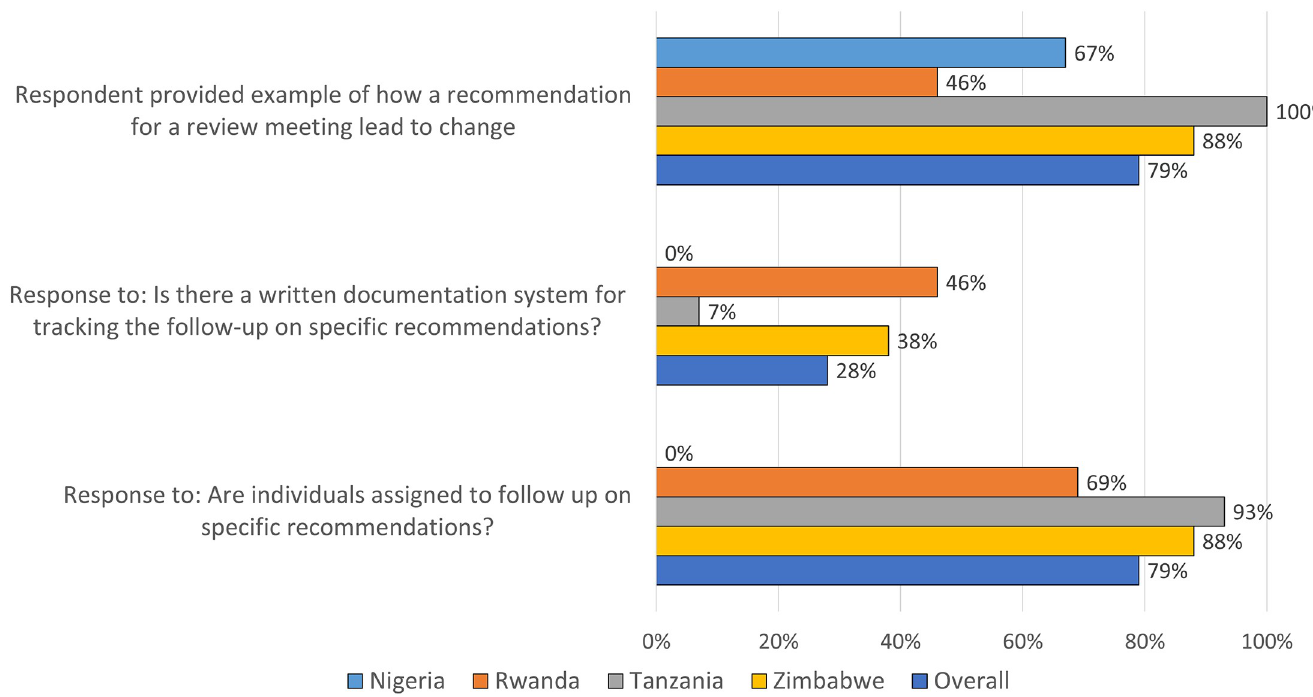
Fig 3. Proportion of facilities reporting follow-up of recommended actions from death reviews (N = 47 facilities).